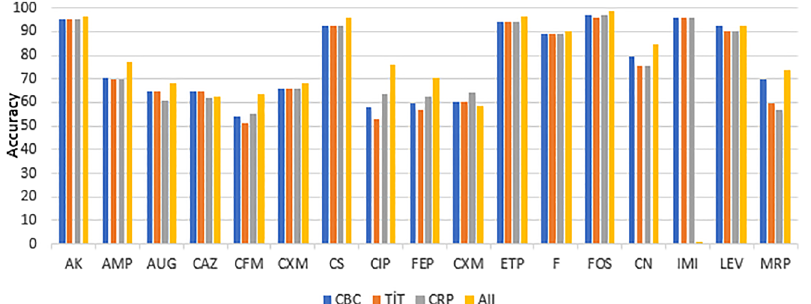
Figure 3: Classification results based on the use of CBC, UA parameters, CRP, and all of these